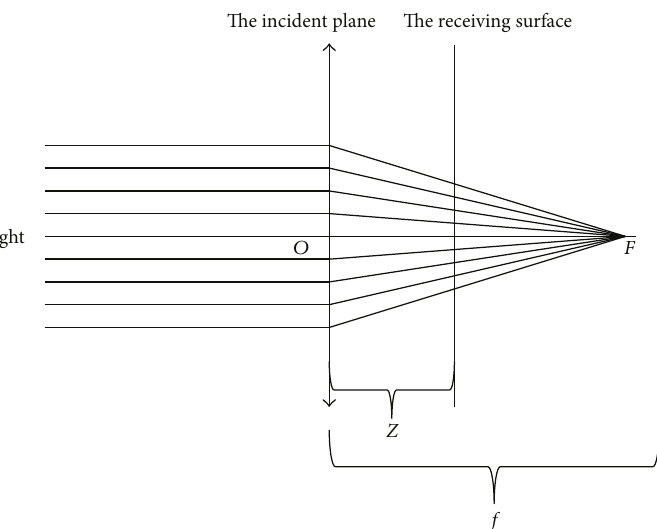
Figure 2: The schematic diagram of parallel incident light path.